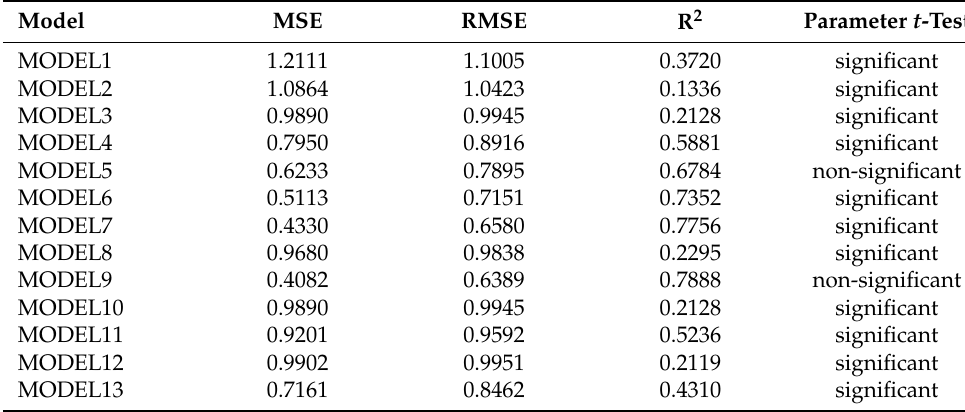
Table 3. Nonlinear OLS summary of residual errors for 25 crown profile